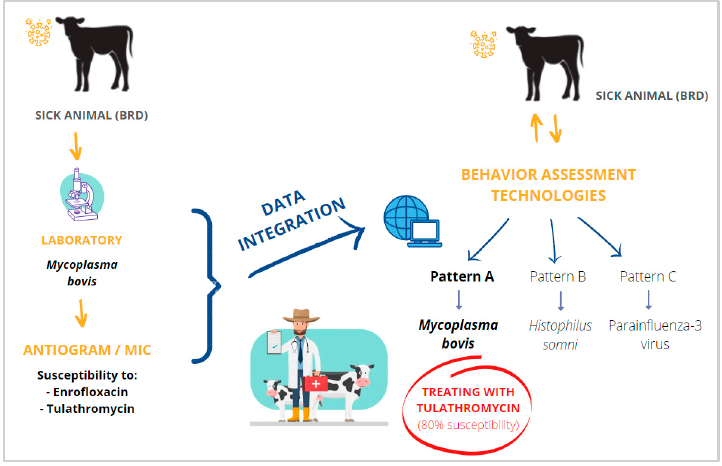
Figure 5. Example of the combination of a conventional diagnosis method (laboratory analysis) with remote early disease identification (REDI) specific for bovine respiratory disease (BRD). Own source.